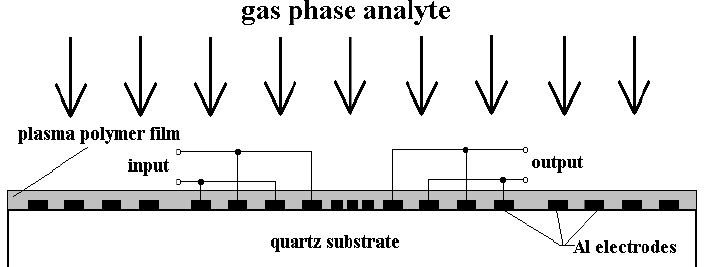
Figure 1. Operation principle of a Rayleigh type surface acoustic wave (RSAW) resonant sensor coated with a chemosensitive